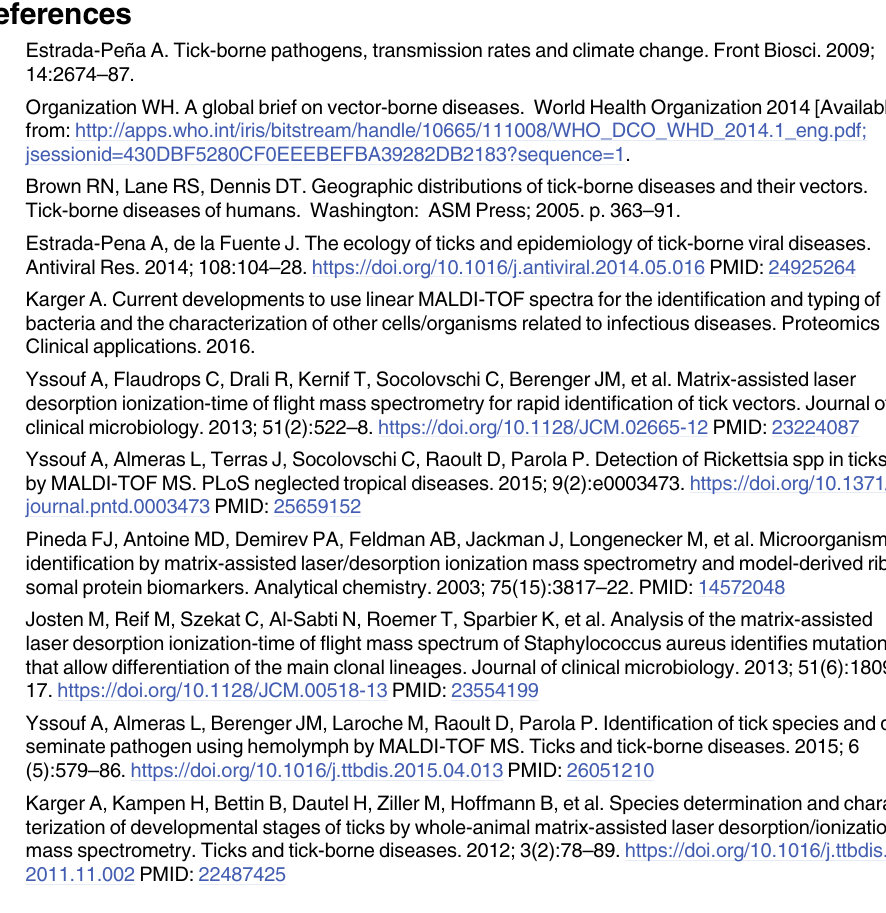
S2 Table. Statistical models calculated with ClinProTools. Detailed presentation of the model parameters in Fig 2 calculated with